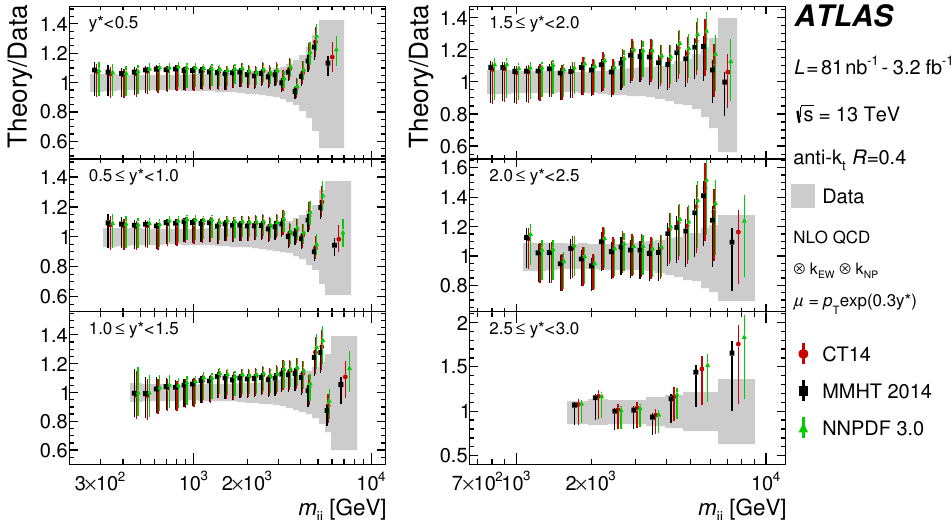
Figure 9 . Comparison of the measured dijet cross-sections and the NLO pQCD predictions shown as the ratios of predictions to the measured cross-sections. The ratios are shown as a function of the jet m jj in six y (cid:3) bins for anti- k t jets with R = 0 : 4. The predictions are calculated using NLOJET++ with three di(cid:11)erent PDF sets (CT14, MMHT 2014, NNPDF 3.0) and non-perturbative and electroweak corrections are applied. The uncertainties of the predictions, shown by the coloured lines, include all the uncertainties discussed in section 9. The grey bands show the total data uncertainty including both the systematic (JES, JER, unfolding, jet cleaning, luminosity) and statistical uncertainties.